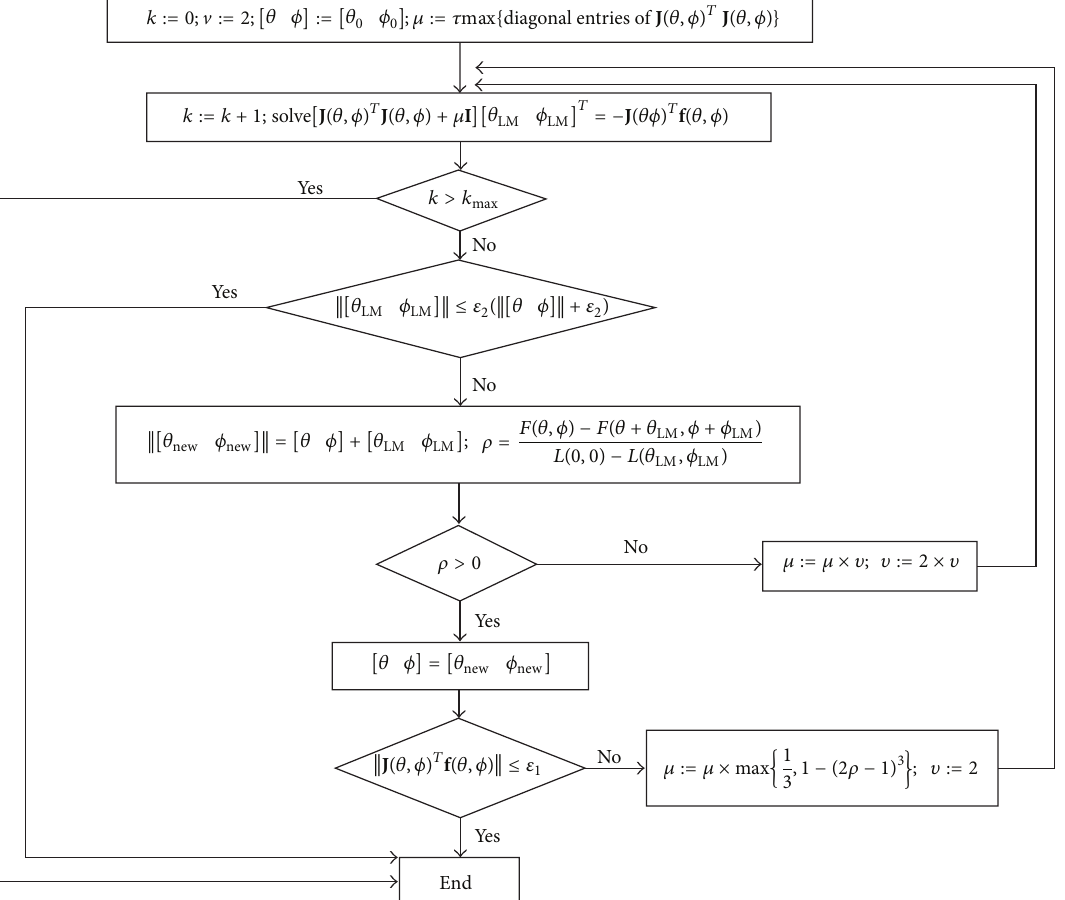
Figure 1: Levenberg-Marquardt algorithm